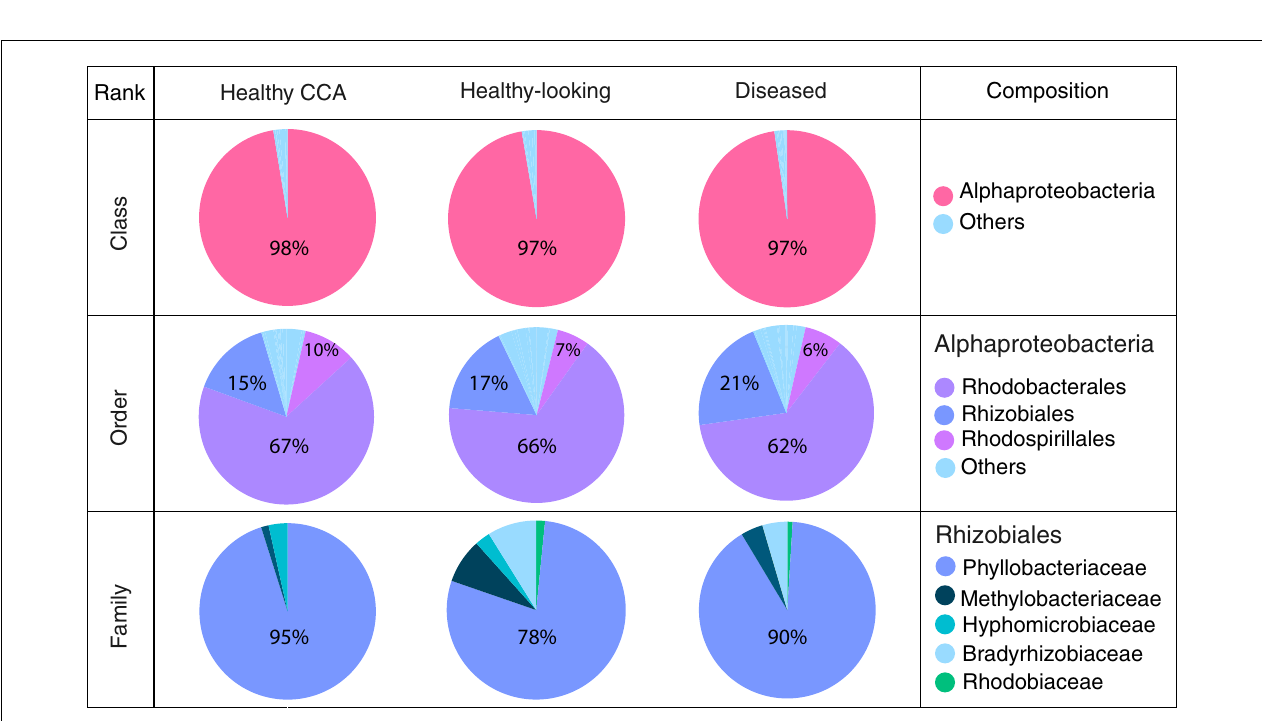
FIGURE 4 | Bacterial community composition at the class, order and family levels in healthy and diseased CCA based on 16S rRNA amplicon sequences.